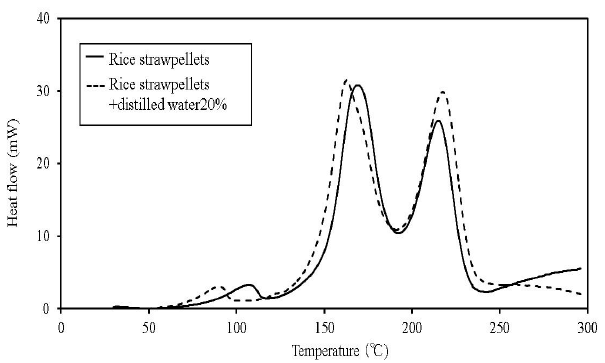
Figure 9. C80 calorimetry curves for rice straw